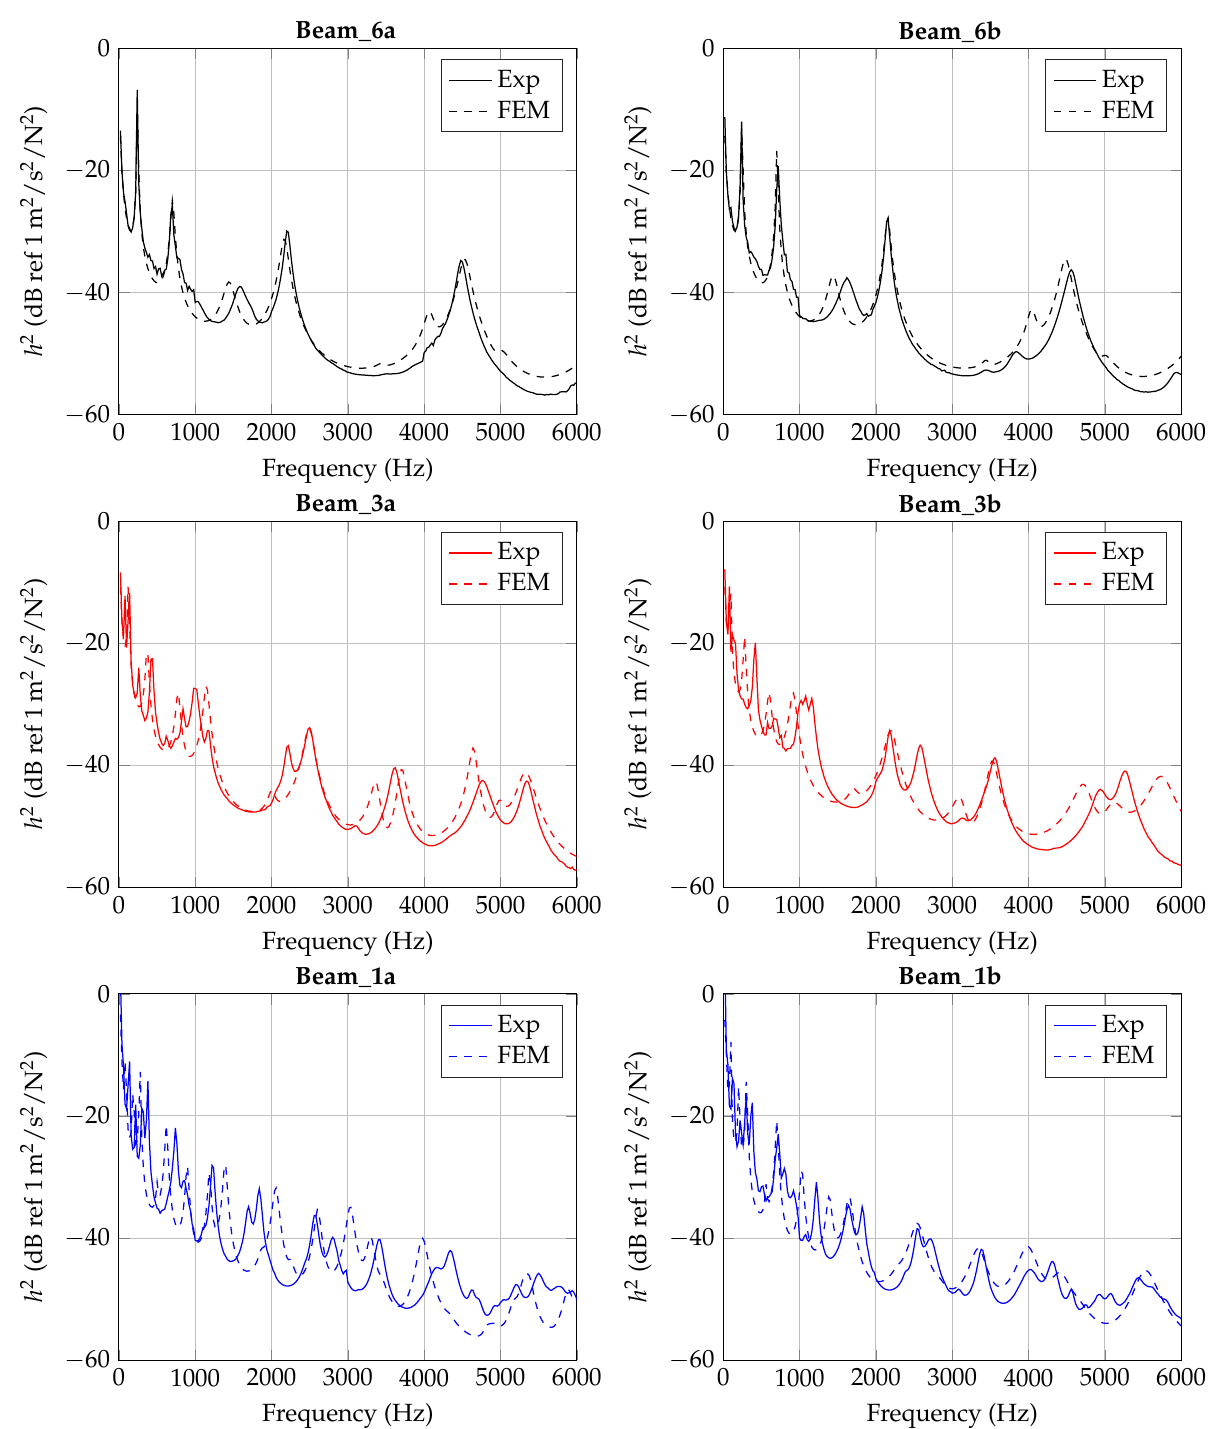
Figure 18. Experimental and numerical response of each specimen with frequency-dependent material parameters E and η